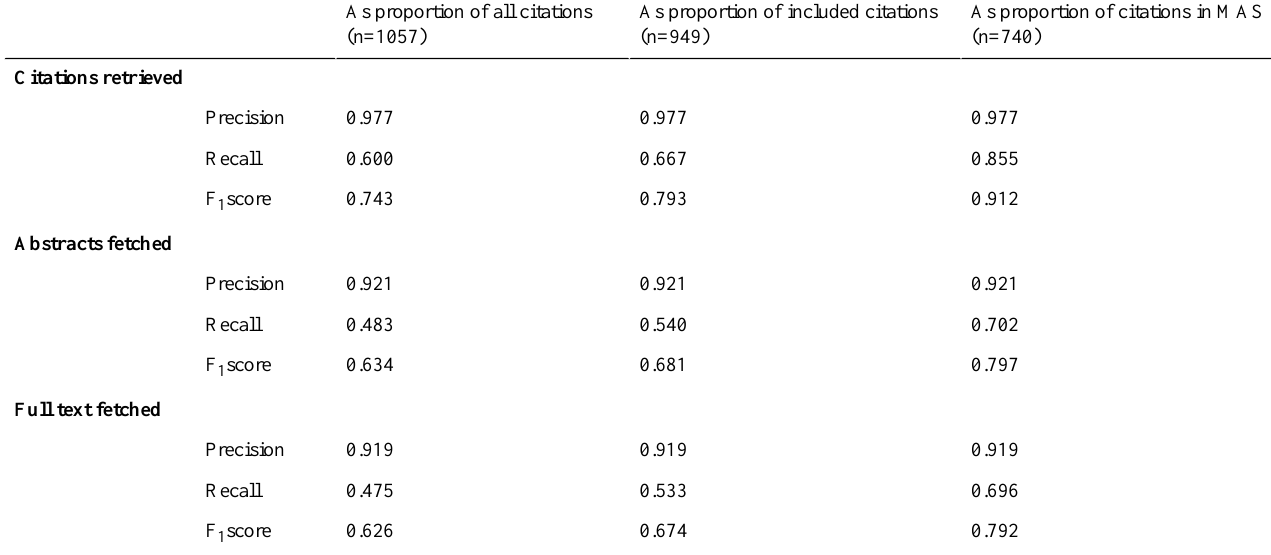
Table 1. Results of citations, abstract, and full text retrieval (precision, recall, and F 1 score of database results fetch, and full text and abstract retrieval, comparing all reference strings, only included citations, and only included citations indexed in